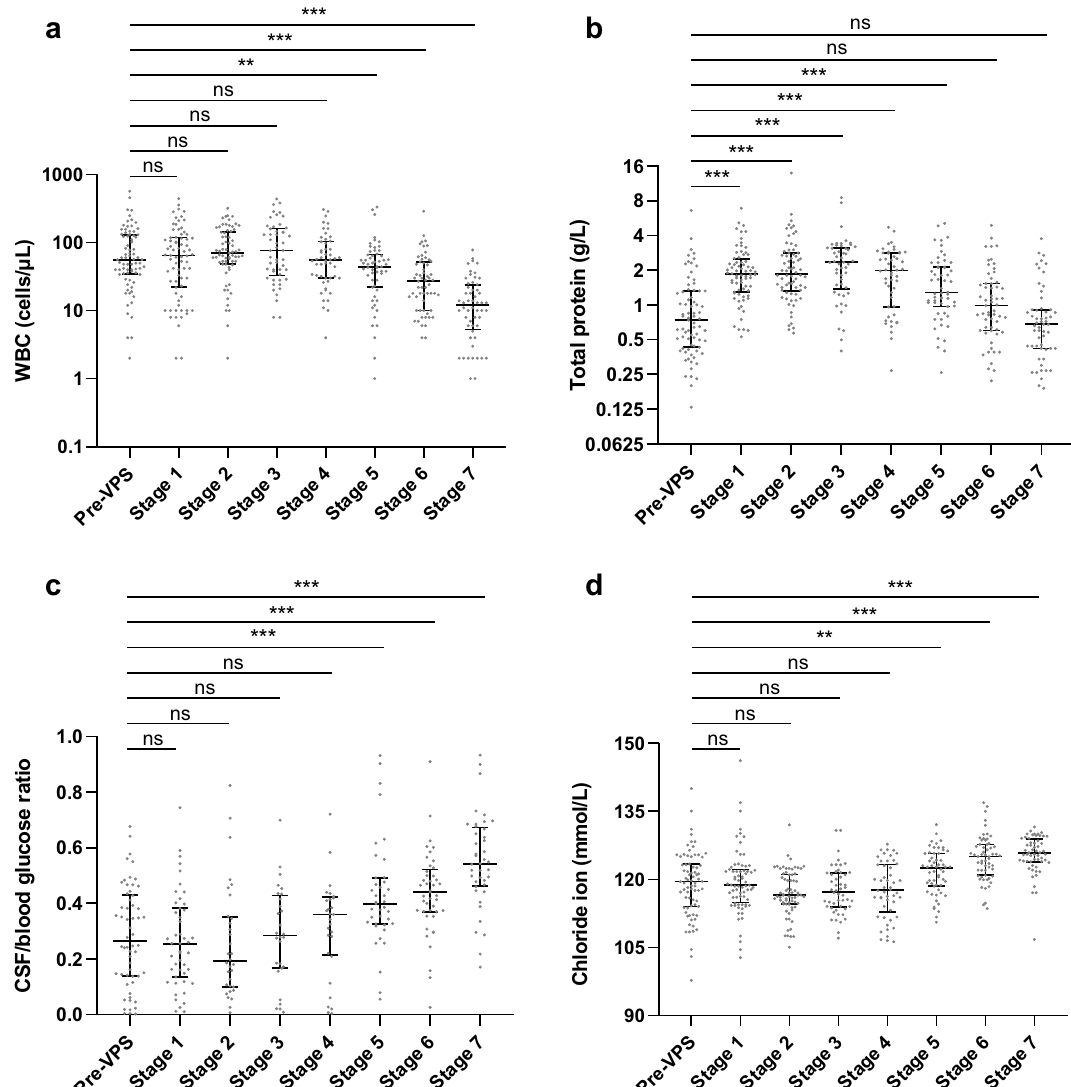
Figure 2. Changes of lumbar CSF parameters over time after VPS placement. ( a ) WBC count remained at the pre-operative level for at least 1 month, and then it began to decline. ( b ) Total protein level was rapidly increased after shunt placement and reached a peak at 2 weeks, then it gradually decreased. ( c ) and ( d ) CSF/blood glucose ratio and chloride ion concentration were remained at the pre-operative level during the first month after shunting surgery, and then gradually elevated. The lack of contemporaneous blood glucose values for each stage were 17, 25, 38, 22, 21, 18, 14, 15 respectively, which resulted in a low amount of CSF/blood glucose ratio data. All data are shown as median with interquartile range. ns: p > 0.05, ** p < 0.01, *** p < 0.001 versus